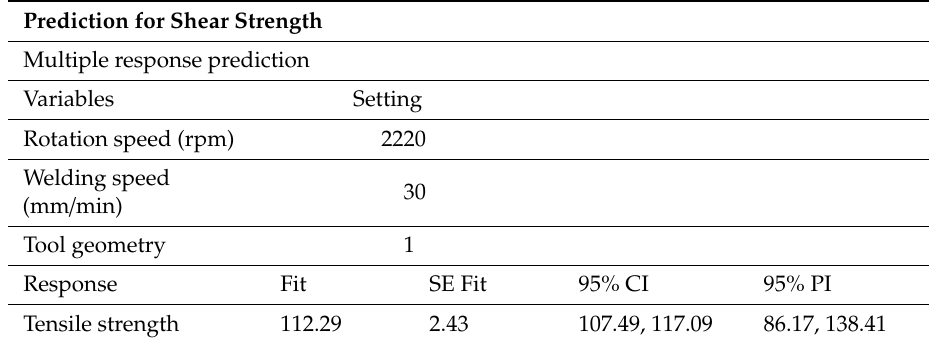
Table 6. The response optimization analysis for tensile